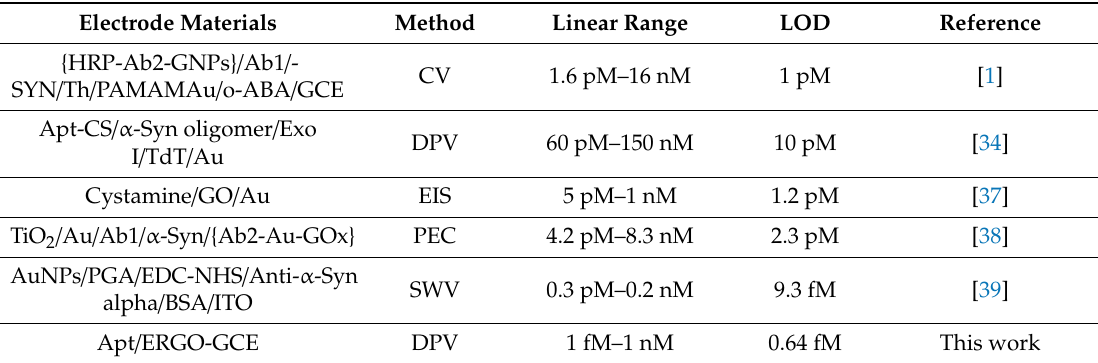
Figure 3. ( A ) Differential pulse voltammetry (DPV) curves of Apt/ERGO-GCE upon the addition of different concentrations of α-Syn oligomer in 0.1 M TBS buffer. The applied potential was scanned from 0.1 to −0.5 V (vs. Ag/AgCl) with an amplitude of 0.05 V, pulse width of 0.05 s, and pulse time of 0.5 s. ( B ) Corresponding calibration plot for i p versus α-Syn oligomer concentration. The inset is the linear relationship between i p and the logarithmic concentration of α-Syn oligomer. Table 1. The comparison of the sensing performance of the proposed sensing strategy with other electrochemical sensing methods for α-Syn oligomer.